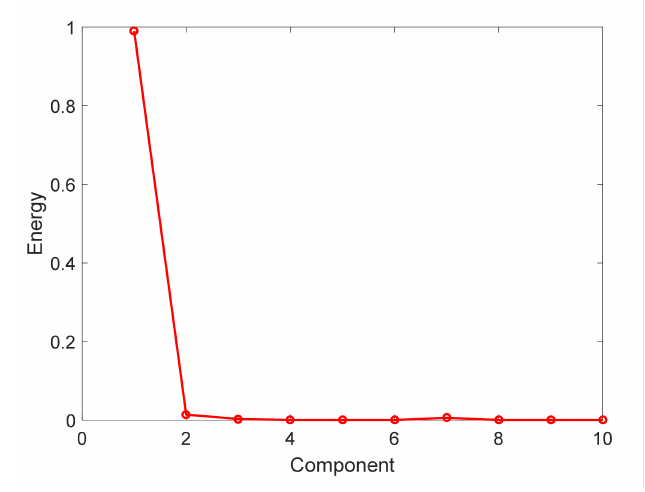
Figure 6. Energy distribution of principal component of the proposed